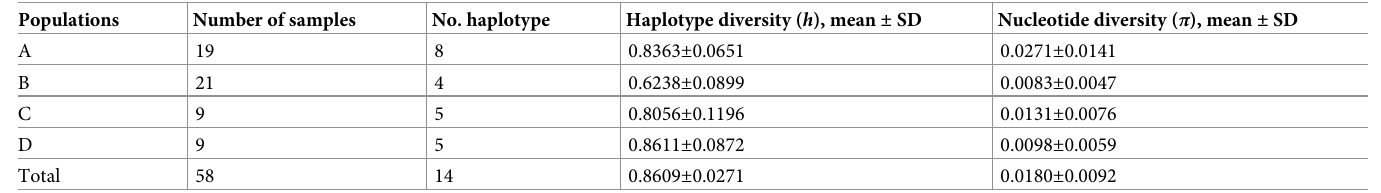
Table 3. Haplotype and nucleotide diversity of 4 populations of Cryptozona siamensis in Thailand, based on their mitochondrial cytochrome c oxidase subunit I gene sequences. Populations Number of